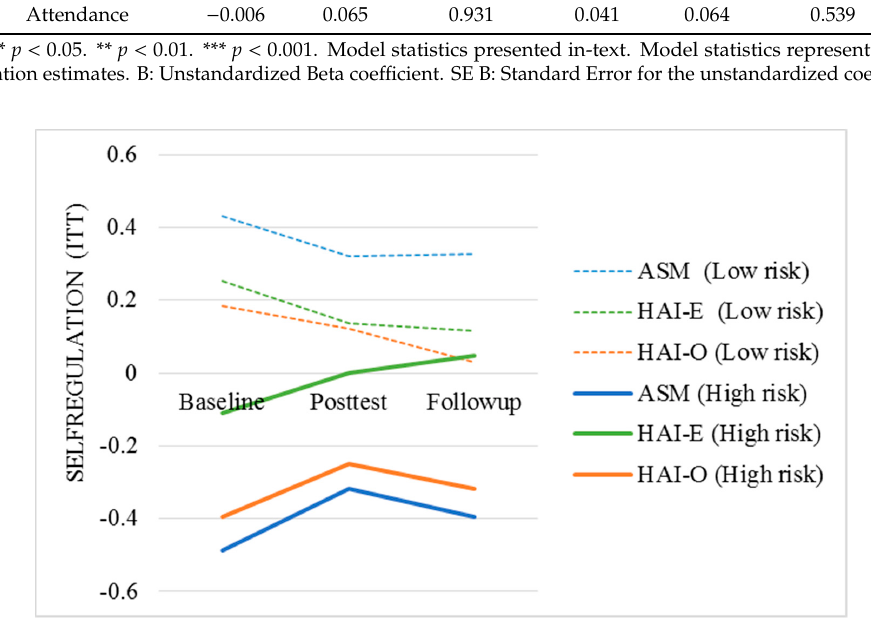
Table 2. Regression analyses modeling moderation e ff ects of mood risk and treatment condition on student’s SELFREGULATION of learning and study strategies. Posttest